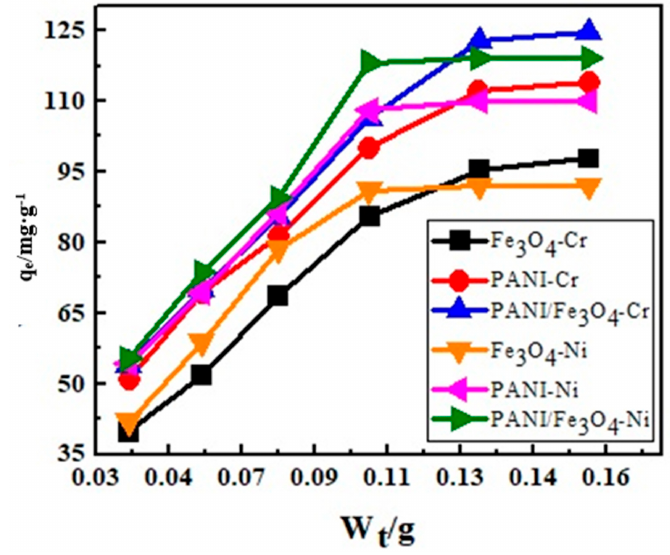
Figure 8. Effect of adsorbent dosage on adsorption of Cr(VI) and Ni(II). Figure 8. E ff ect of adsorbent dosage on adsorption of Cr(VI) and